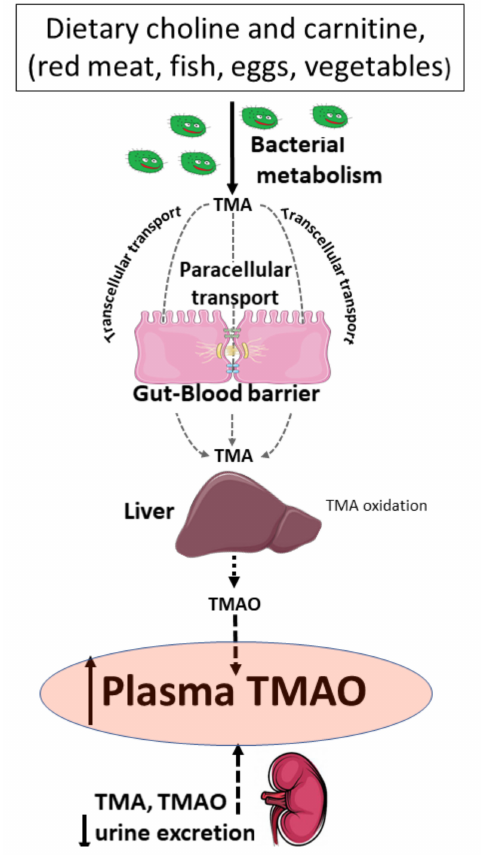
Figure 5. Factors a ff ecting the levels of trimethylamine (TMA) and trimethylamine oxide (TMAO) in the plasma. Levels of TMA and TMAO in the plasma depend on the diet, bacterial metabolism, gut-to-blood penetration of TMA, liver oxidation of TMA to form TMAO, and the excretion of TMA and TMAO by the